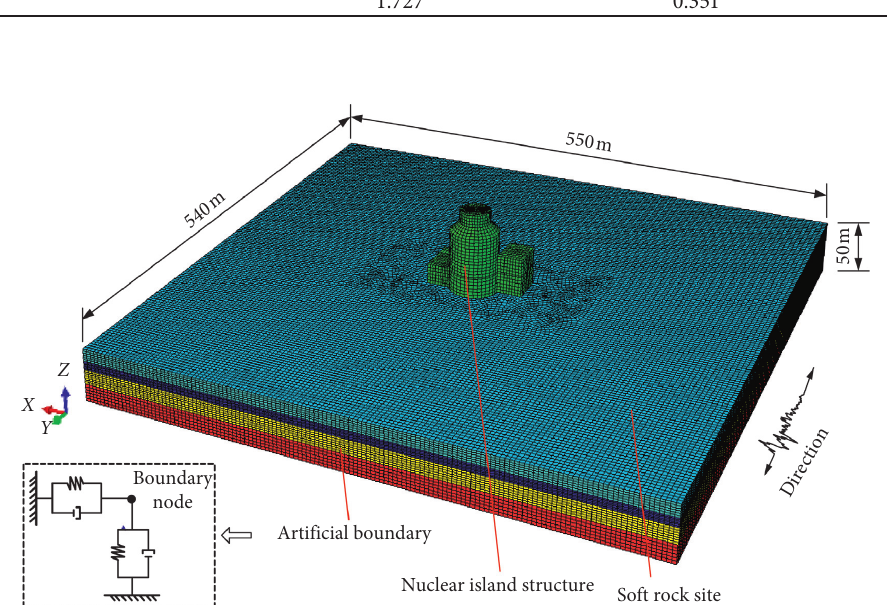
Figure 6: Calculation model of the SR foundation-nuclear island structure